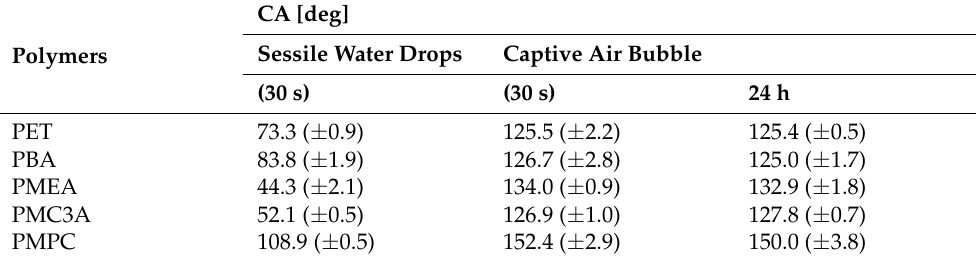
Table 2. CAs on the polymer surface *.